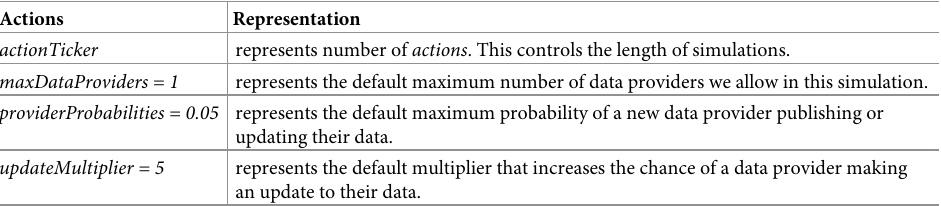
Table 1. Parameters used in the incentive